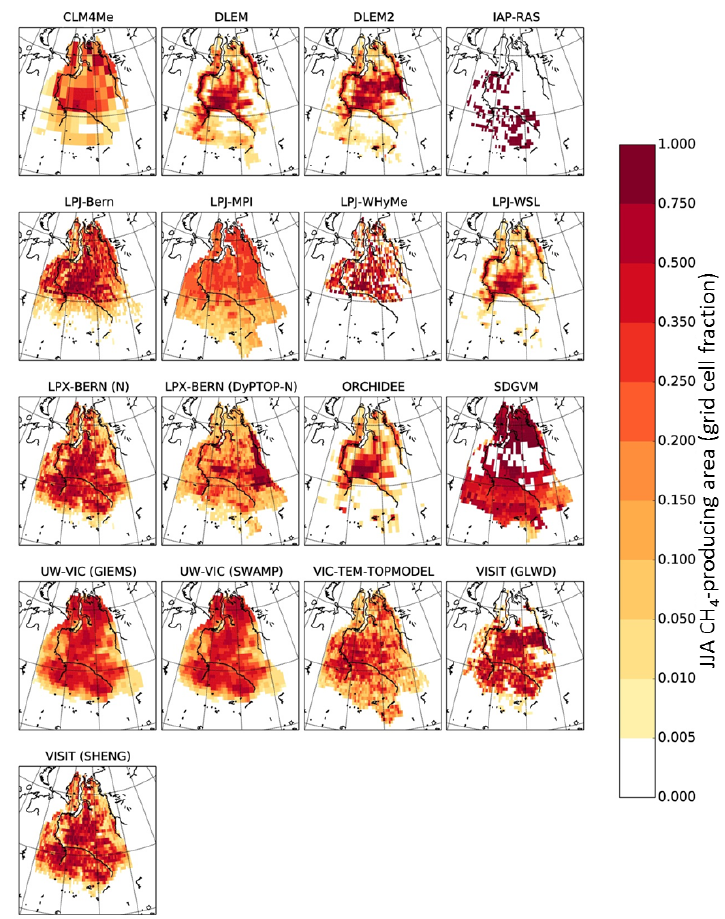
Figure 7. Maps of average JJA CH 4 -producing area (fraction of grid cell area) from participating models. Table 7. Temporal coefficients of variation (CV) of annual CH 4 emissions, 1993–2004.